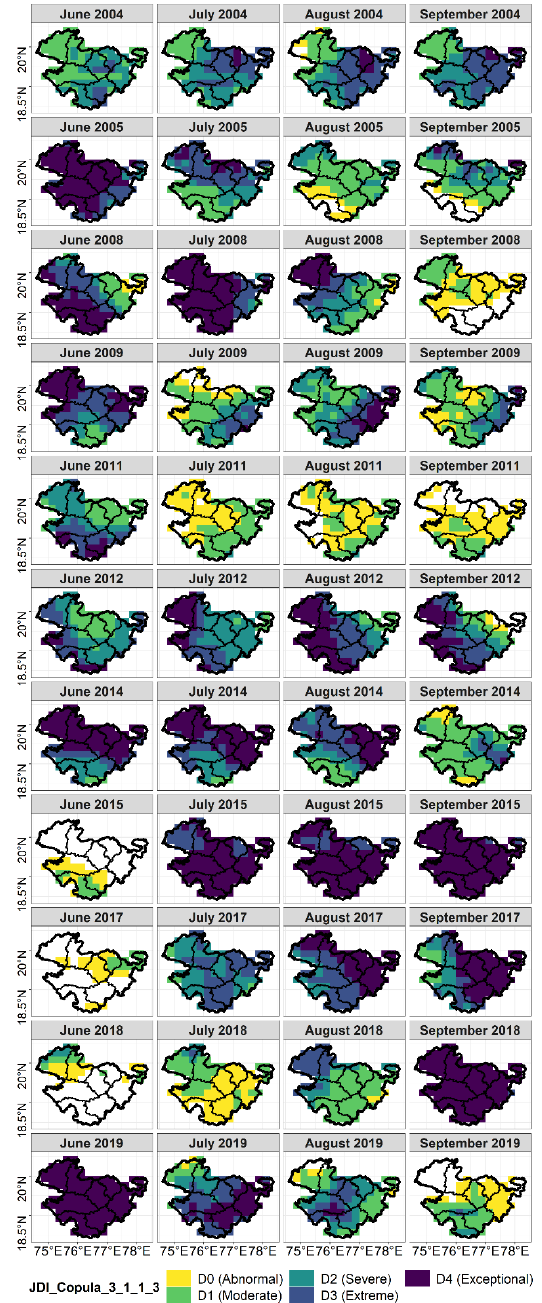
Figure 7. Spatial distribution of drought severity in Kharif season of different drought years detected by using JDI_Copula.